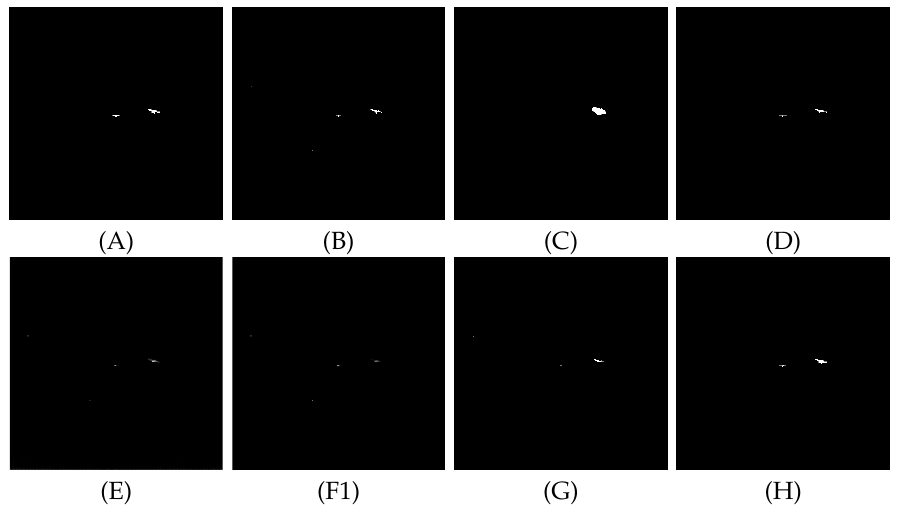
Figure A12. ( A – H ) shows the detection results of eight algorithms PSTNN, TV-PCP, VNTFR, anisotropy, ASTTV, SRWS, RPCA and propose method, respectively, under sequence F.